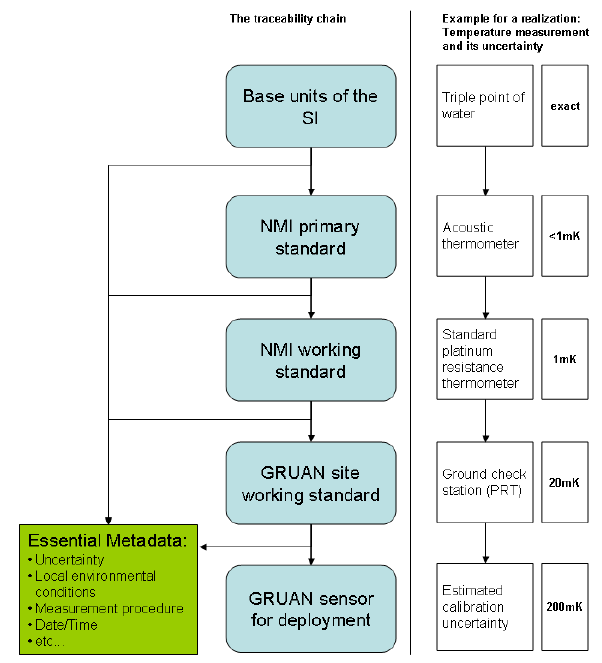
Fig. 1. Conceptual traceability chain illustrating how the calibra- tion of a sensor for deployment is tied to the realization of a SI unit. Each calibration step is defined by a comparison between two mea- surements with a stated, realistic uncertainty. All relevant details of the measurement comparison that can influence the measurement result must be recorded. SI: International System of units, from the French: Syst ` e me international d’unit ´ e s. NMI: National Metrology